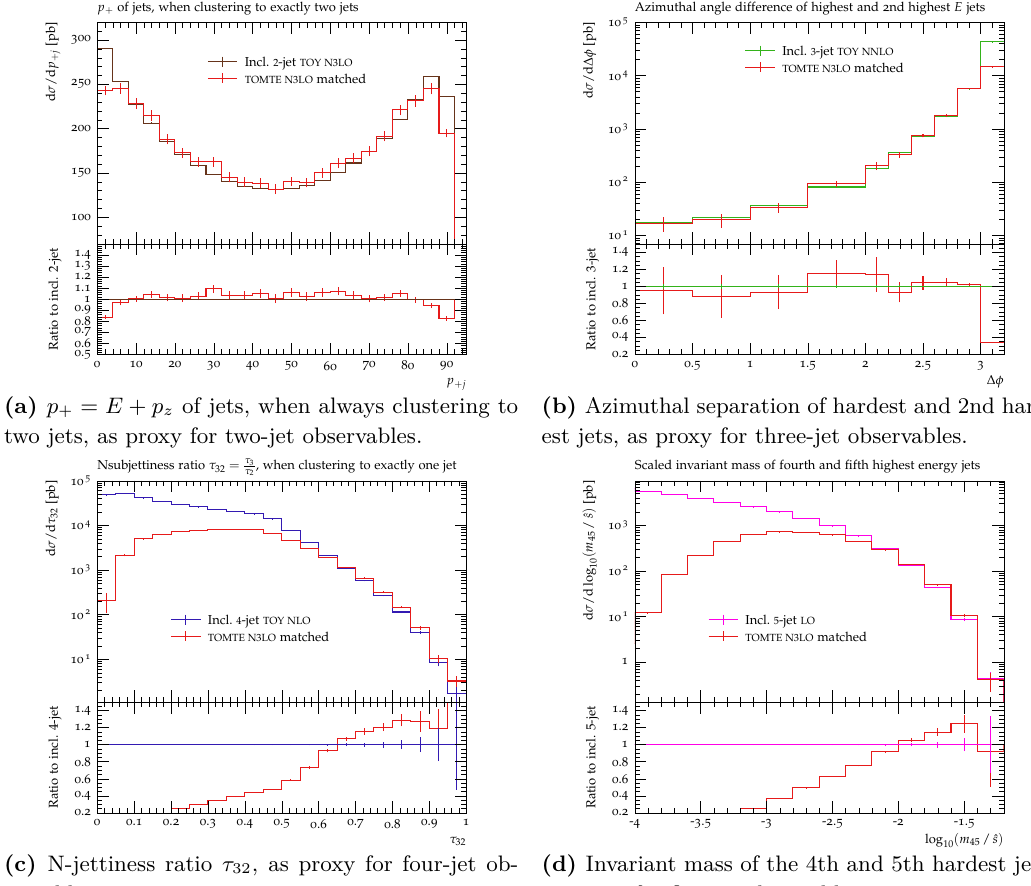
(c) N-jettiness ratio τ 32 , as proxy for four-jet ob- (d) Invariant mass of the 4th and 5th hardest jets, servables. as proxy for five-jet observables. Figure 3 . Comparison of toy fixed-order curves (with conservative S (Φ n ) regularization) and full Tomte results. Bars denote statistical errors. See main text for